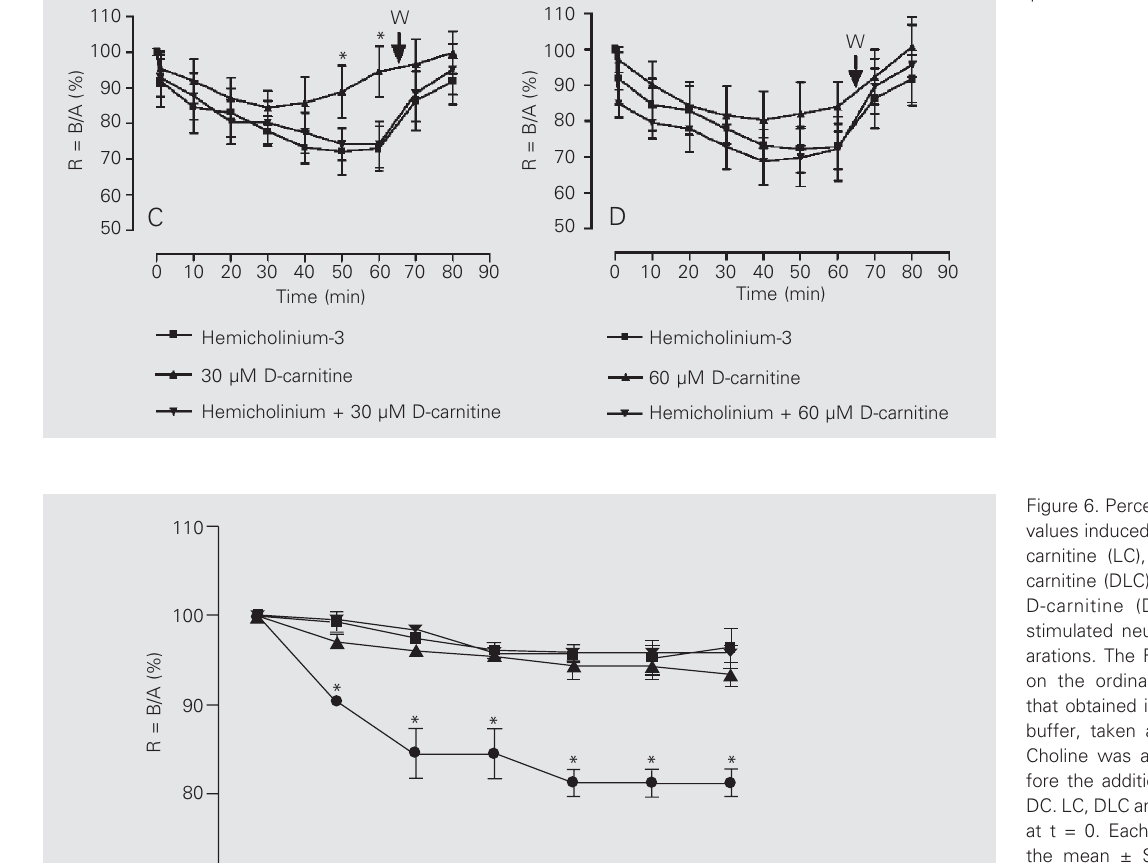
Figure 5. Percent reduction in R-values induced by 60 µM L- carnitine and/or hemicholinium- 3 (A), 60 µM DL-carnitine and/or hemicholinium-3 (B) and 30 µM D-carnitine and/or hemicholi- nium-3 (C), and 60 µM D-car- nitine and/or hemicholinium-3 (D), in indirectly stimulated neu- romuscular preparations. The R- ratio is reported on the ordinate as percent of that obtained in drug-free Krebs buffer, taken as 100% (t = 0). The drugs were added at t = 0. W indicates re- placement of drug-free Krebs buffer (four times). Each point represents the mean ± SEM of 5 experiments. *P < 0.05 com- pared to control (Student t -test).